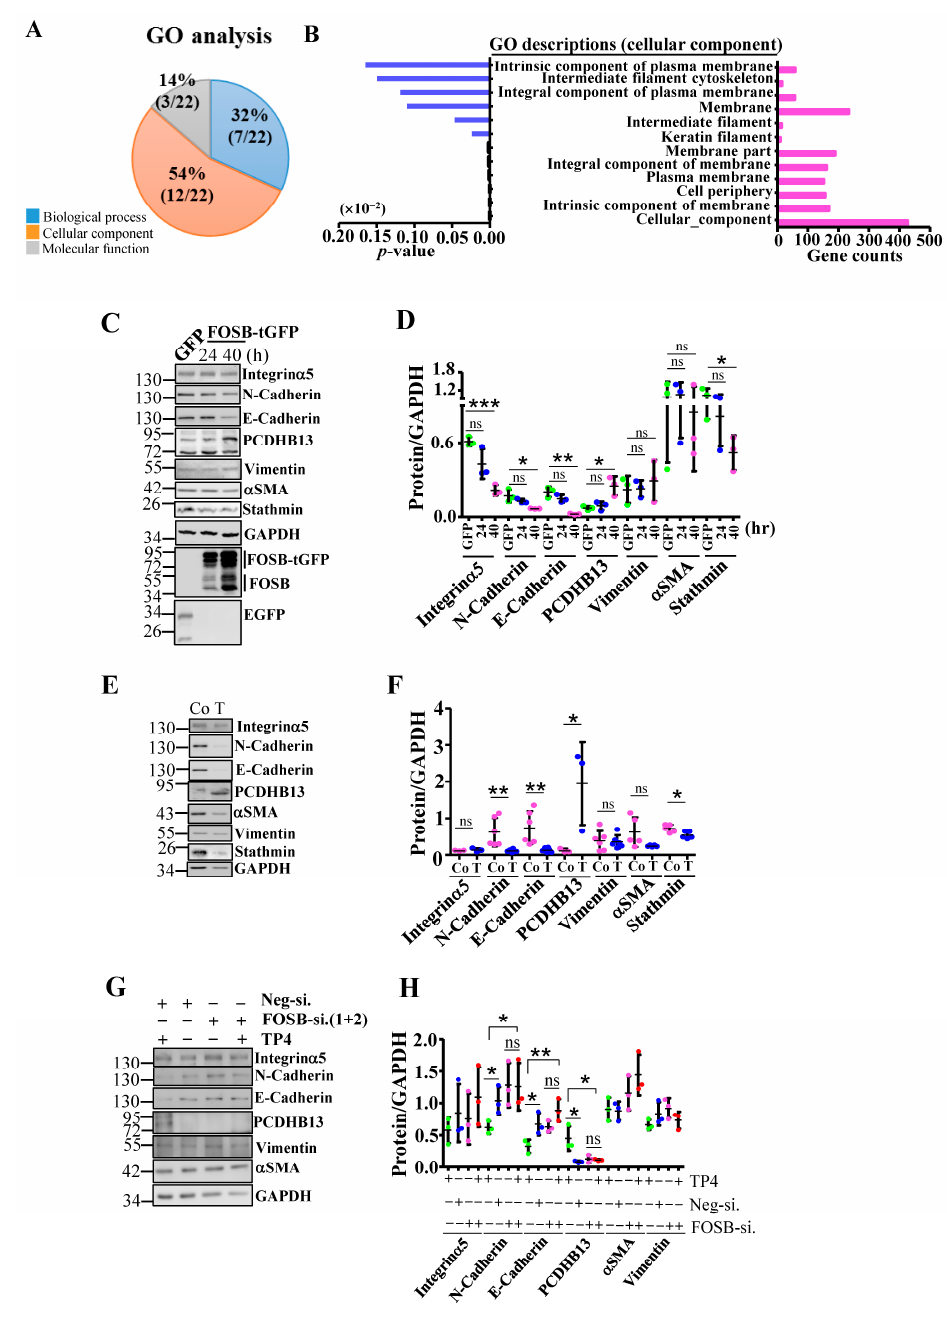
Figure 2. Loss of cytoskeletal integrity upon FOSB induction. ( A , B ) Gene ontology (GO) analyses of dysregulated genes revealed three distinct functional categories ( A ). Twelve out of